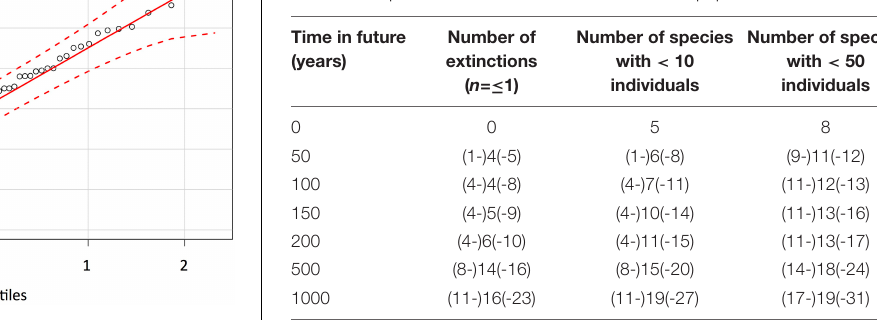
TABLE 3 | Projection of extinctions in the wild, and other thresholds, forward in time based upon estimated rates of decline of natural